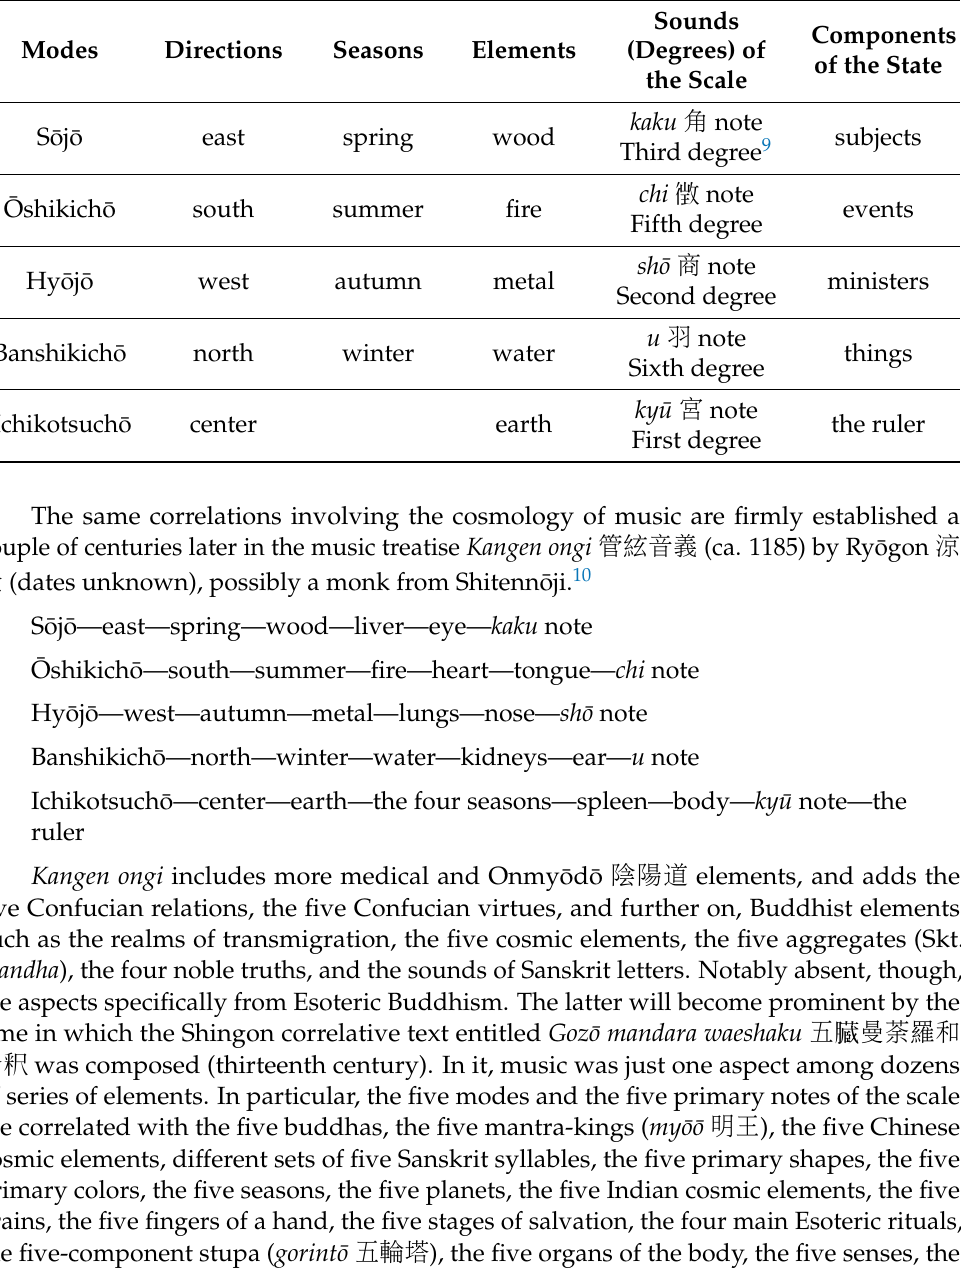
Table 1. List of correlations between musical modes and other aspects of